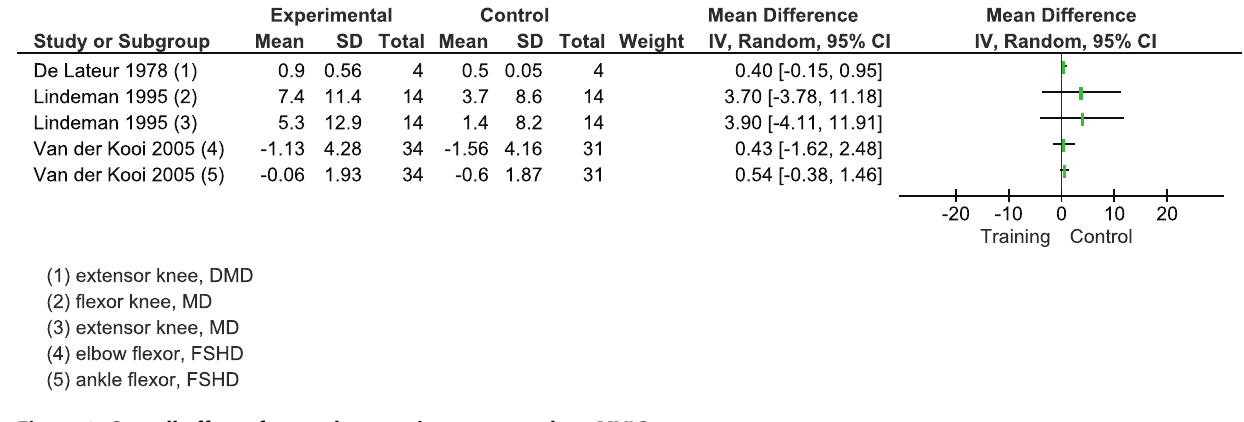
Figure 3. Overall effect of muscular exercise on strength as MVIC.